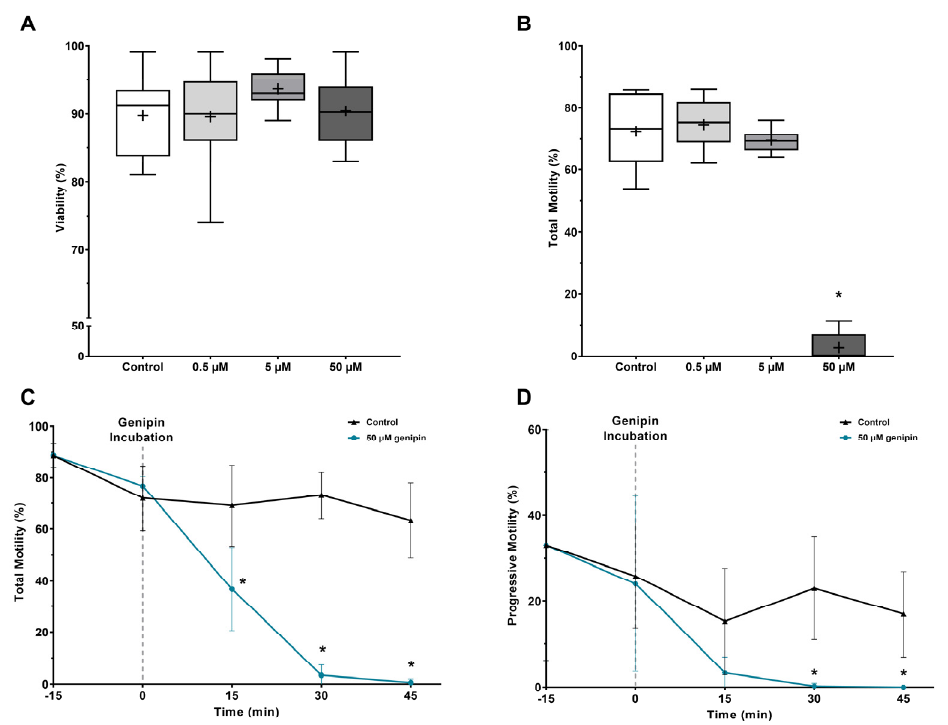
Figure 4. Evaluation of human spermatozoa viability and motility after UCPs inhibition by increas- ing concentrations of genipin (0.5, 5, and 50 µM) for 3 h. ( A ) Human spermatozoa viability was determined by eosin–nigrosin staining (n = 10). ( B ) Effect of UCPs inhibition on total motility of human spermatozoa (n = 10). ( C ) Evaluation of the time of action of 50 µM genipin on total and ( D ) progressive motility (n = 6). Results are expressed as Tukey’s boxplot (median, 25th to 75th percen- tiles ± 1.5 IQR) ( A , B ) or mean ± SD ( C , D ). + − Represents group average. Significantly different results are expressed as: * − Relative to the control group.